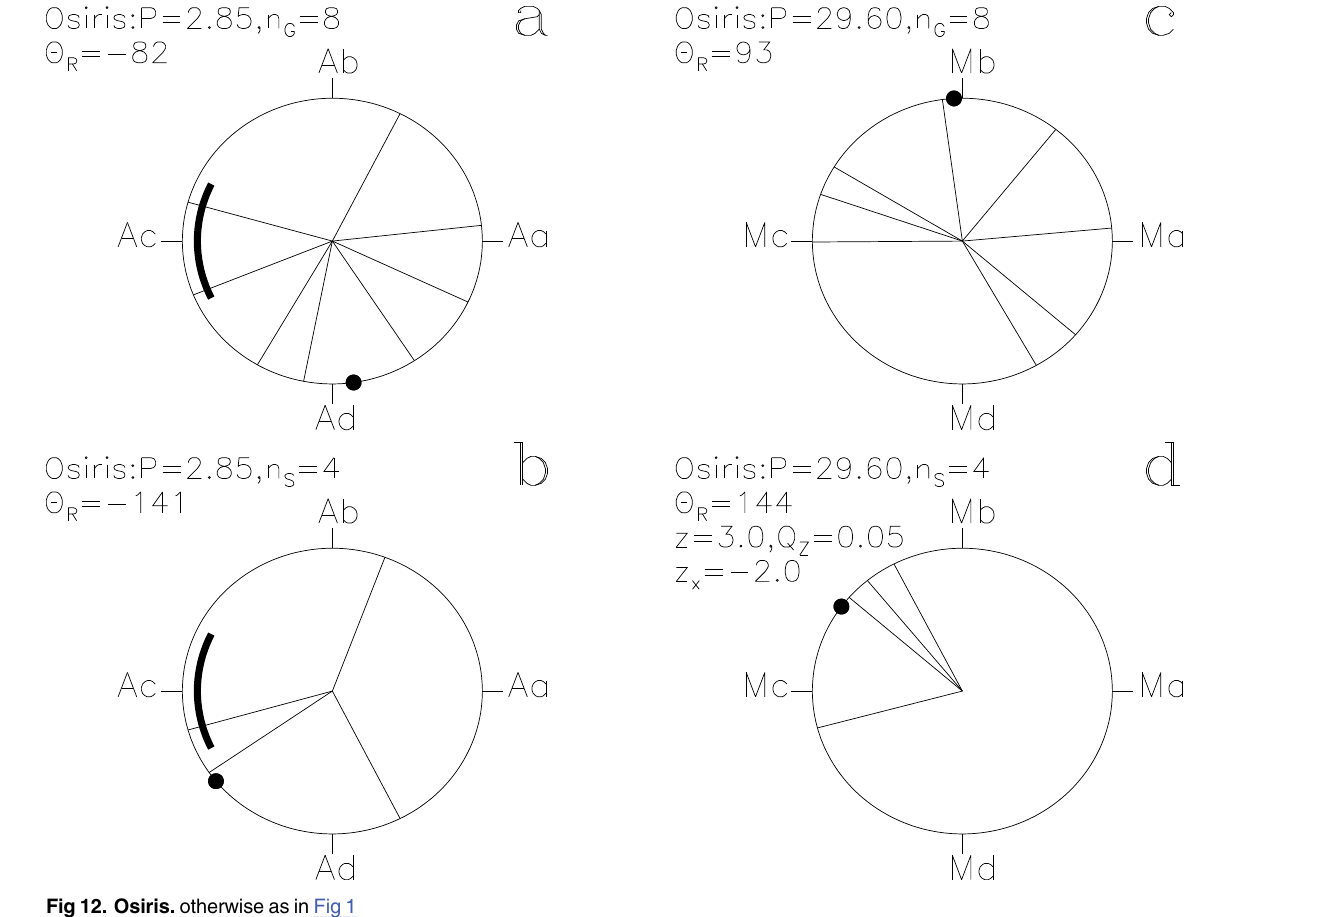
Fig 12. Osiris. otherwise as in Fig